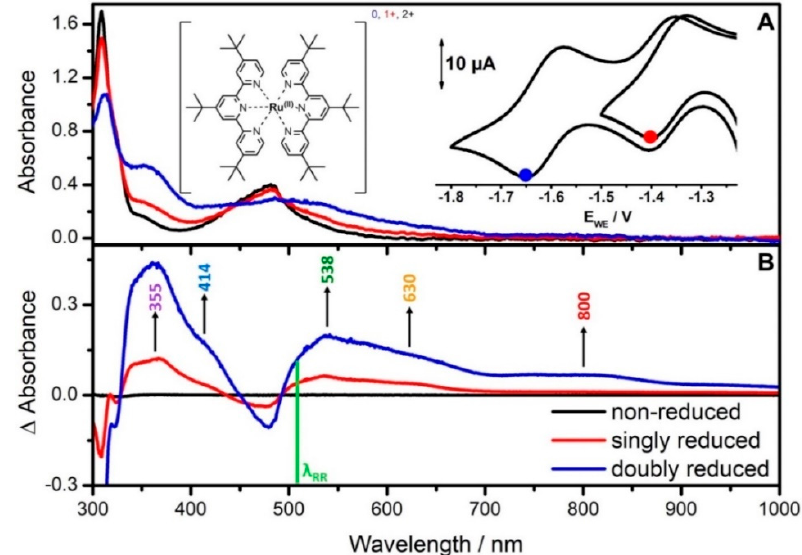
Figure 1. In situ ( A ) UV-vis-NIR absorption and ( B ) difference spectra of [Ru(tbtpy) 2 ](PF 6 ) 2 collected during the first (red) and the second (blue) reduction wave. Insets in A: Molecular structure and CV of [Ru(tbtpy) 2 ](PF 6 ) 2 in ACN containing the 0.1 M TBABF 4 electrolyte, recorded in the spectro-electrochemistry (SEC) cell. The electrode potential for acquisition of the absorption spectra is marked in the CV (scan rate 5 mV/s, Pt-gauze working, Pt-counter, and Ag/AgCl-pseudo-reference electrodes).